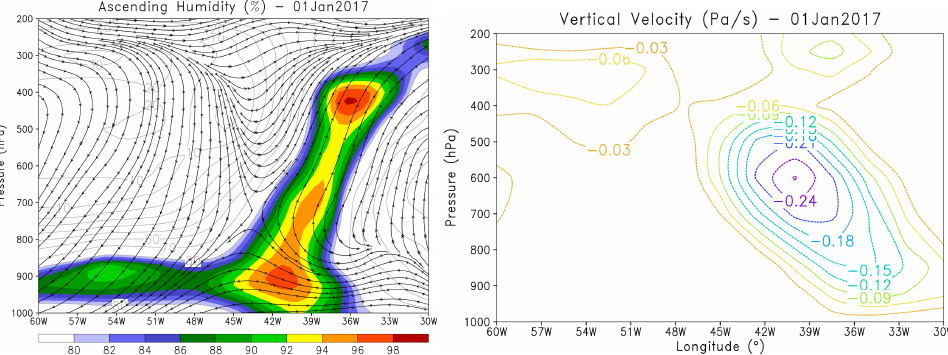
Figure 5. The ascending humidity profile and omega (Pa/s) at standard levels on 1 January